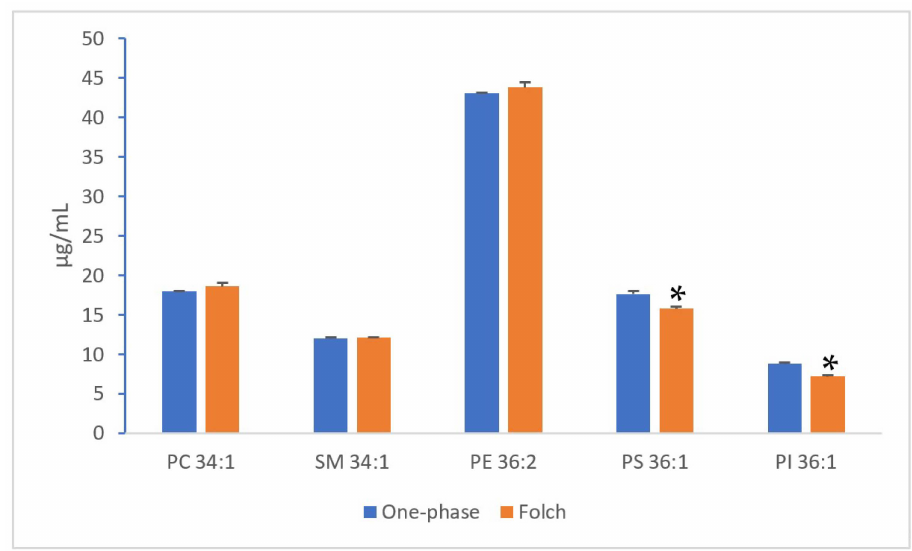
Figure 3. Yield of some phospholipid species (from Milk-11) as influenced by the extraction methods. Sample dilution factor (final analysed sample volume vs. the starting milk volume) was 44-fold and 40-fold for the one-phase method and the Folch method, respectively. LC separation was by the Eclipse XDB-C8 column using the multistep gradient elution. Lipid concentration was measured using the one-point IS calibration method. Each column is the mean of 3 analyses ( ± SD). * Indicates significant difference by t -test ( p < 0.05).